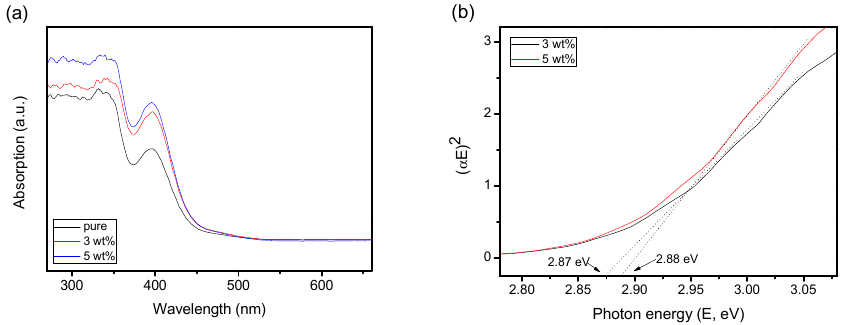
Figure 1. ( a ) UV-Vis spectra of MoS 2 , 3 wt%, and 5 wt% CoO@meso–CN@MoS 2 heterojunction photocatalysts. ( b ) The band-gap energy of samples.